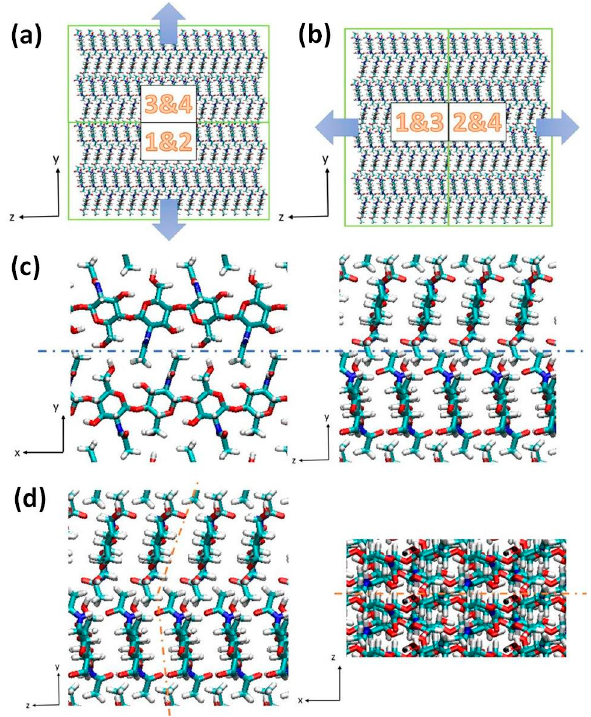
Figure 8 . Two sets of SMD simulation. The green blocks represent different parts of the model and the numbers demonstrate the combination of the four parts divided previously. The blue arrows demonstrate the direction of pulling force. ( a ) Pulling along the inter-chain direction; ( b ) Pulling along inter-sheet direction; ( c , d ) illustrate the inter-chain and inter-sheet directions, where the dotted blue and orange lines correspond to the inter-chain and inter-sheet interactions respectively.